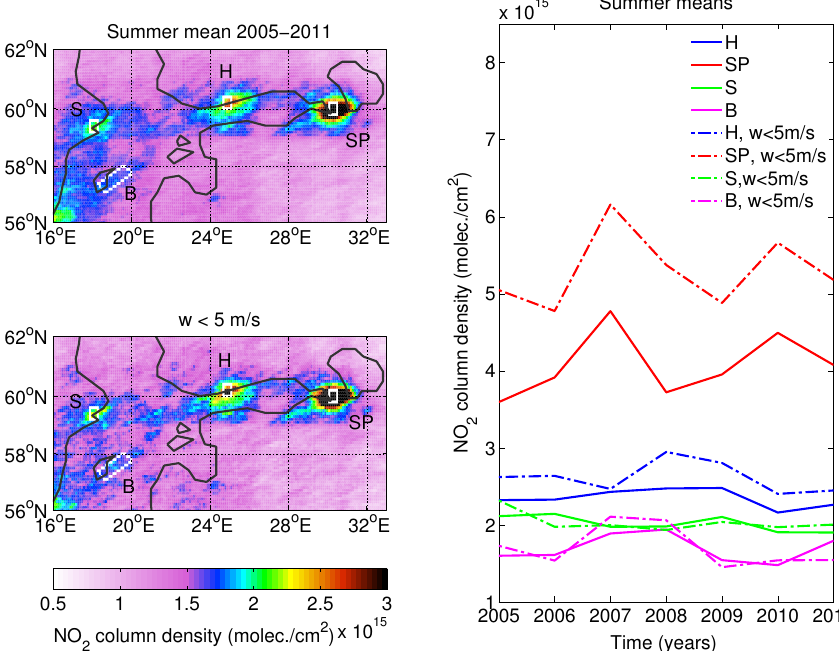
Figure 1. OMI tropospheric NO 2 column averaged over the summer days in 2005–2011, under all wind and weak wind conditions (upper and lower-left panel, respectively). The main coastal cities and the selected area in the Baltic Sea region are marked with their initials: Helsinki (H, 60.2 ◦ N, 25.0 ◦ E), Stockholm (S, 59.3 ◦ N, 18.0 ◦ E), Saint Petersburg (SP, 59.95 ◦ N, 30.3 ◦ E) and the Baltic Sea (B, 57.5 ◦ N, 19 ◦ E). The right panel illustrates the time series of the seasonal means of NO 2 for these locations. The grid pixels included in the summer means are marked by the white boxes in the left